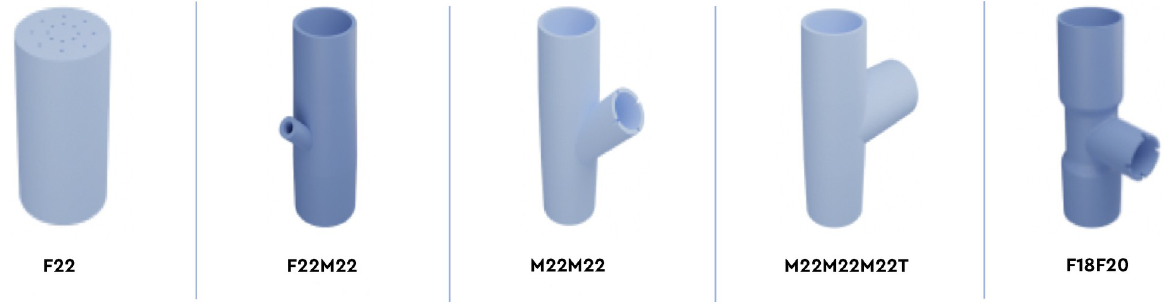
Fig 1. Five models of 3D-printed ventilation fittings: F22 (references 1 and 2), F22M22 (references 4, 4, and 10), M22M22 (references 5, 6, and 11), M22M22M22T (references 7 and 8), and F18F20 (references 9).